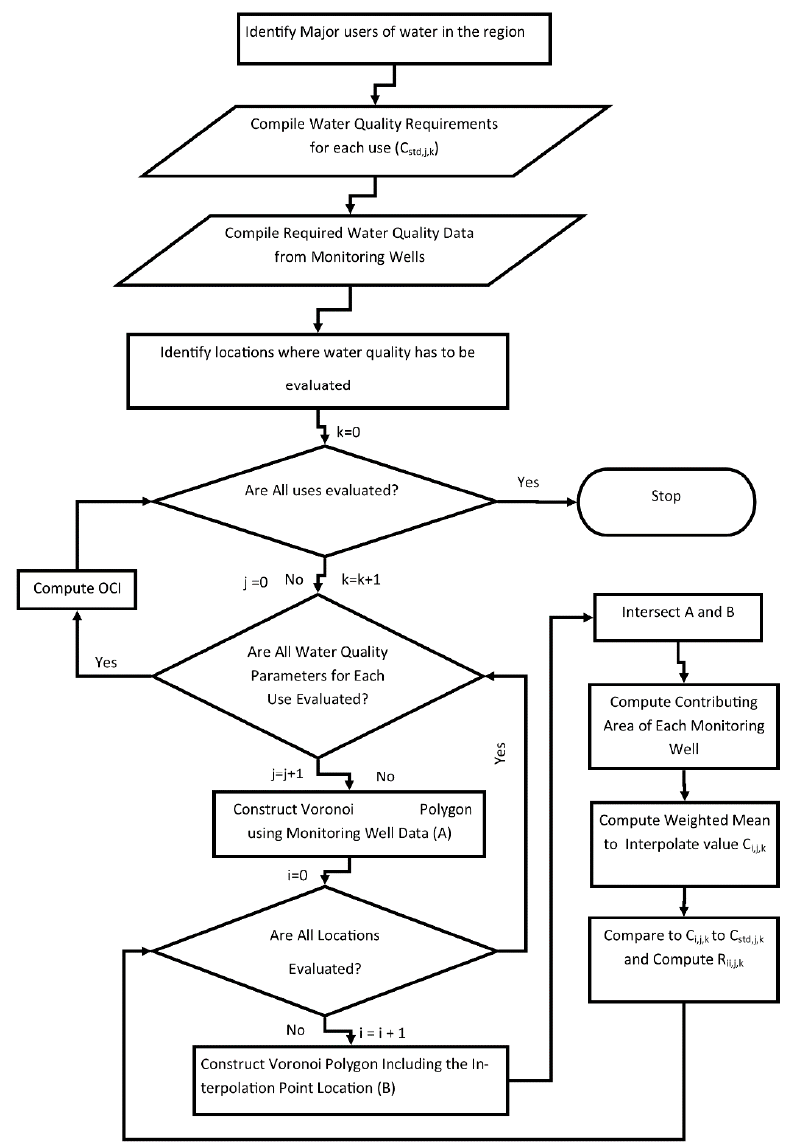
Figure 2. Flow chart of the fit for purpose (FFP) evaluation procedure.